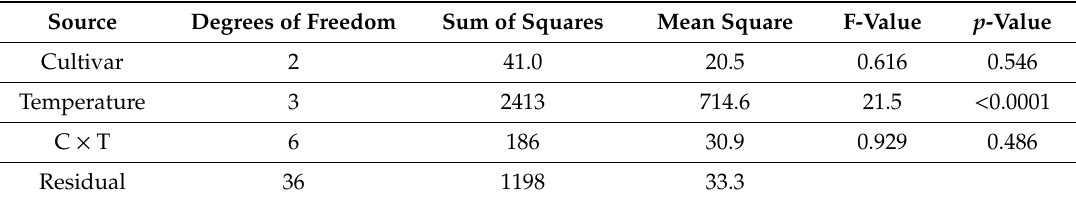
Table A4. Analysis of variance for photosynthetic rates measured at 500 µ mol mol − 1 C i for three soybean cultivars grown at 20 ◦ C.